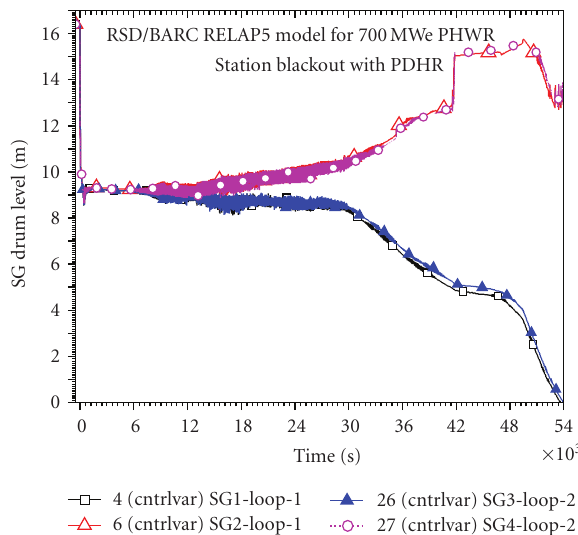
Figure 10: SG level variation case-6 minutes delay in valving in